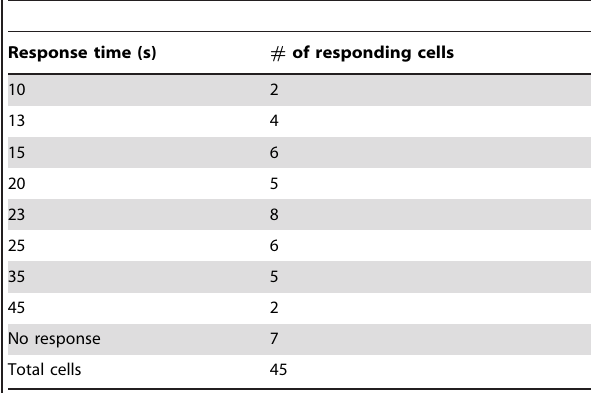
Table 2. The variability of time of onset of the calcium response to antigen (DNP-BSA)